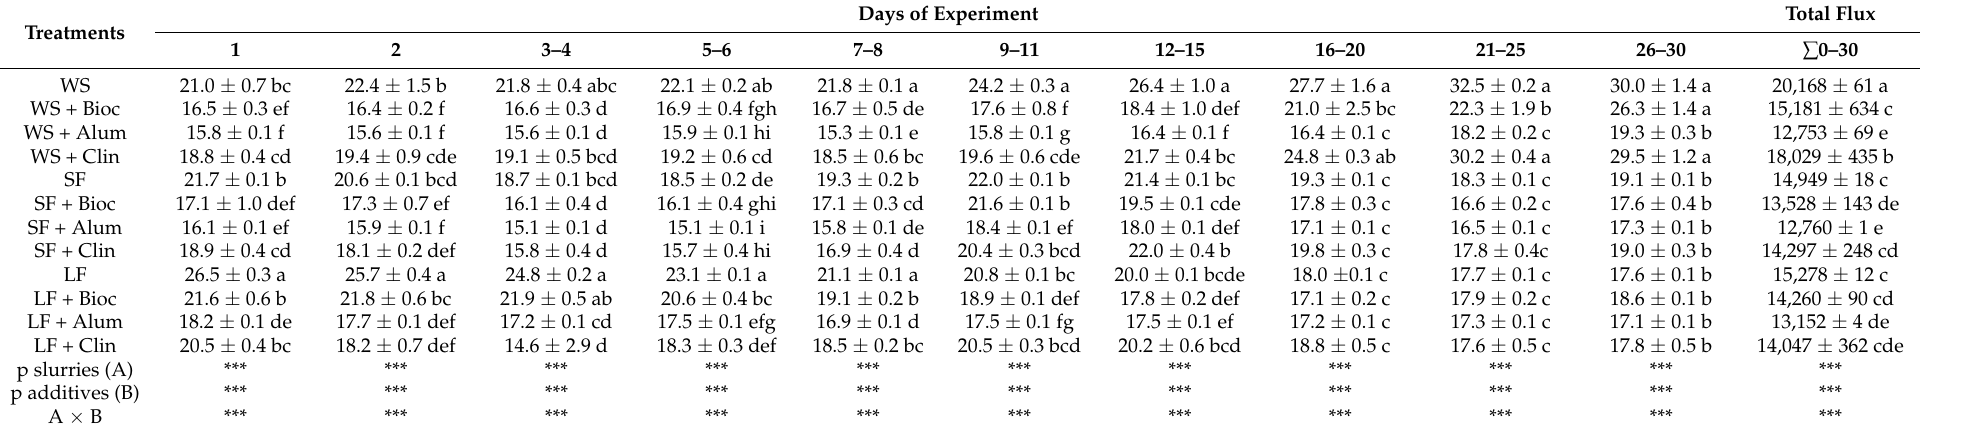
Table 6. Average carbon dioxide fluxes (g m − 2 h − 1 ) and total flux (g m − 2 ) from each treatment (mean ± standard deviation) ( n =